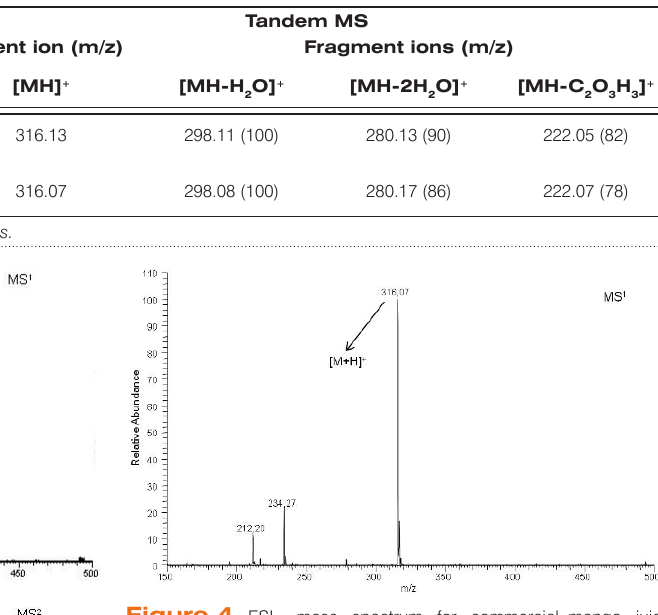
Table 4. HPLC-ESI(+)-MS/MS characteristics of GA standard solution and mango juice